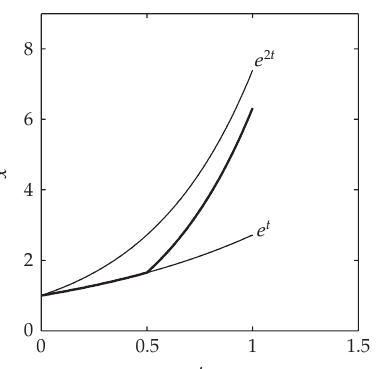
Figure 2: The solution of the di ff erential inclusion that corresponds to switching from k (cid:7) 1 (cid:5) control law 1 (cid:6) to k (cid:7) 2 (cid:5) control law 2 (cid:6) at the moment t (cid:7) 1 / 2 .